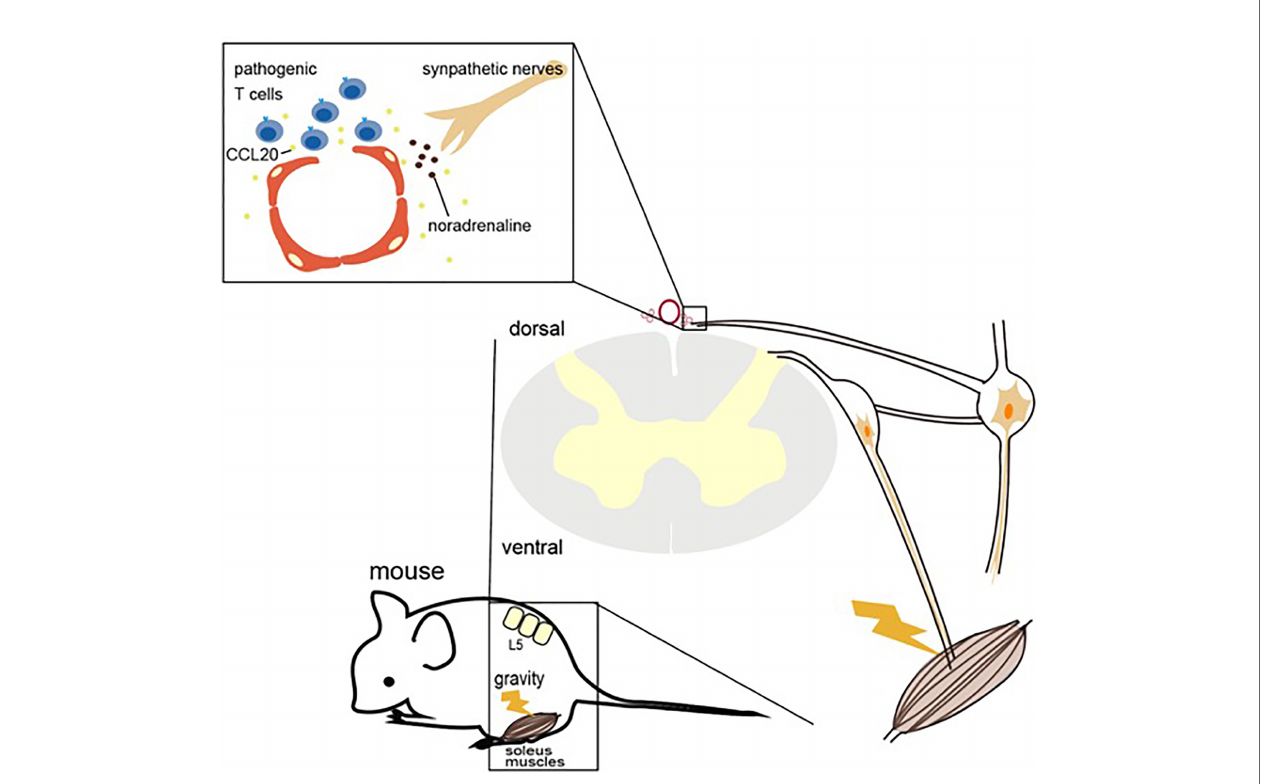
FIGURE 2 | Light gateway re fl ex. The light gateway re fl ex. Photopic light stimulates a high expression of noradrenaline and adrenaline to downregulate a1A- adrenoceptor